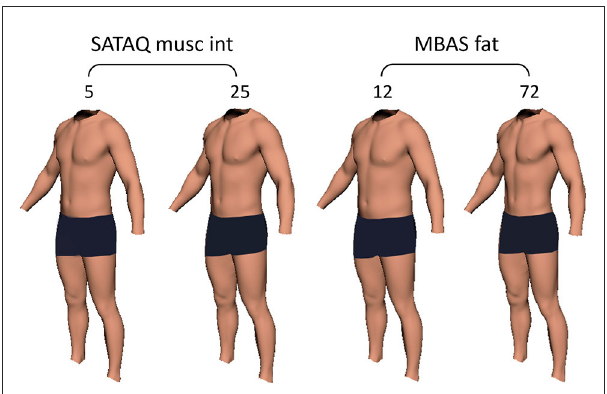
FIGURE5 Illustrations of male bodies corresponding to the SATAQ muscle internalization scores of 5 (minimum) and 25 (maximum), as well as the MBAS fat scores of 12 (minimum) and 72 (maximum). In each case all other parameters from the model in Table 4 were held at their respective sample means. Using the modeling technique of Maalin et al. (2021), set to the nearest 1kg increment, when the observer has a SATAQ score of 5 and 25, total fat mass is 11 and 12kg, respectively, and skeletal muscle mass is 45 and 54kg, respectively. When the observer has an MBAS fat score of 12 and 72, total fat mass is 16 and 6kg, respectively, and skeletal muscle mass is 46 and 53kg,